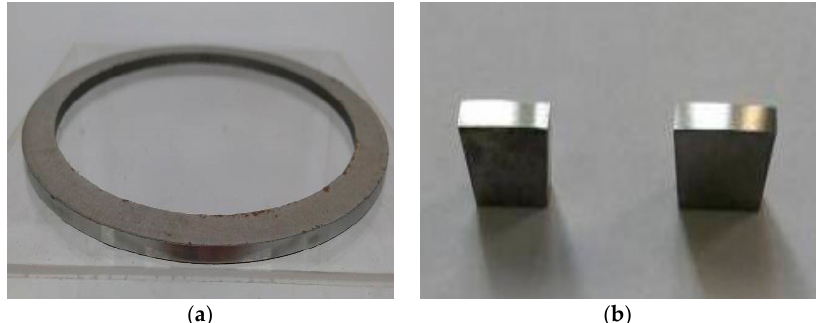
Figure 2. Piston ring and samples. ( a ) Piston ring; ( b ) piston ring samples.